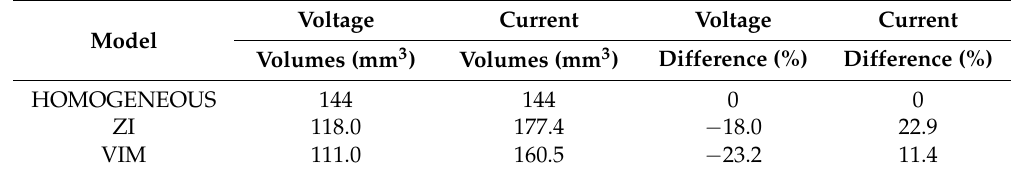
Figure 6. Electric field (EF) distribution (0.2 V/mm) in voltage and current control stimulation mode. ( a ) Homogeneous model ( b ) patient-specific model, ZI and ( c ) VIM; ( d ) Axial, sagittal and coronal cut planes, crossing at the middle point of the active contact ( e ) closer view of the axial plane of the preoperative MRI at the ZI and ( f ) electric field isocontours (0.2 V/mm) of lead 3389 for homogeneous and patient-specific brain models. EF obtained at 3 V (first and third column) and 3.4 mA (second and fourth column). A: anterior, P: posterior, S: superior, I: inferior, L: left, R: right. Table 1. Homogeneous and patient-specific electric field (EF) volumes (<0.2 V/mm isosurface) achieved with different operating modes and the relative difference between each target and the homogeneous